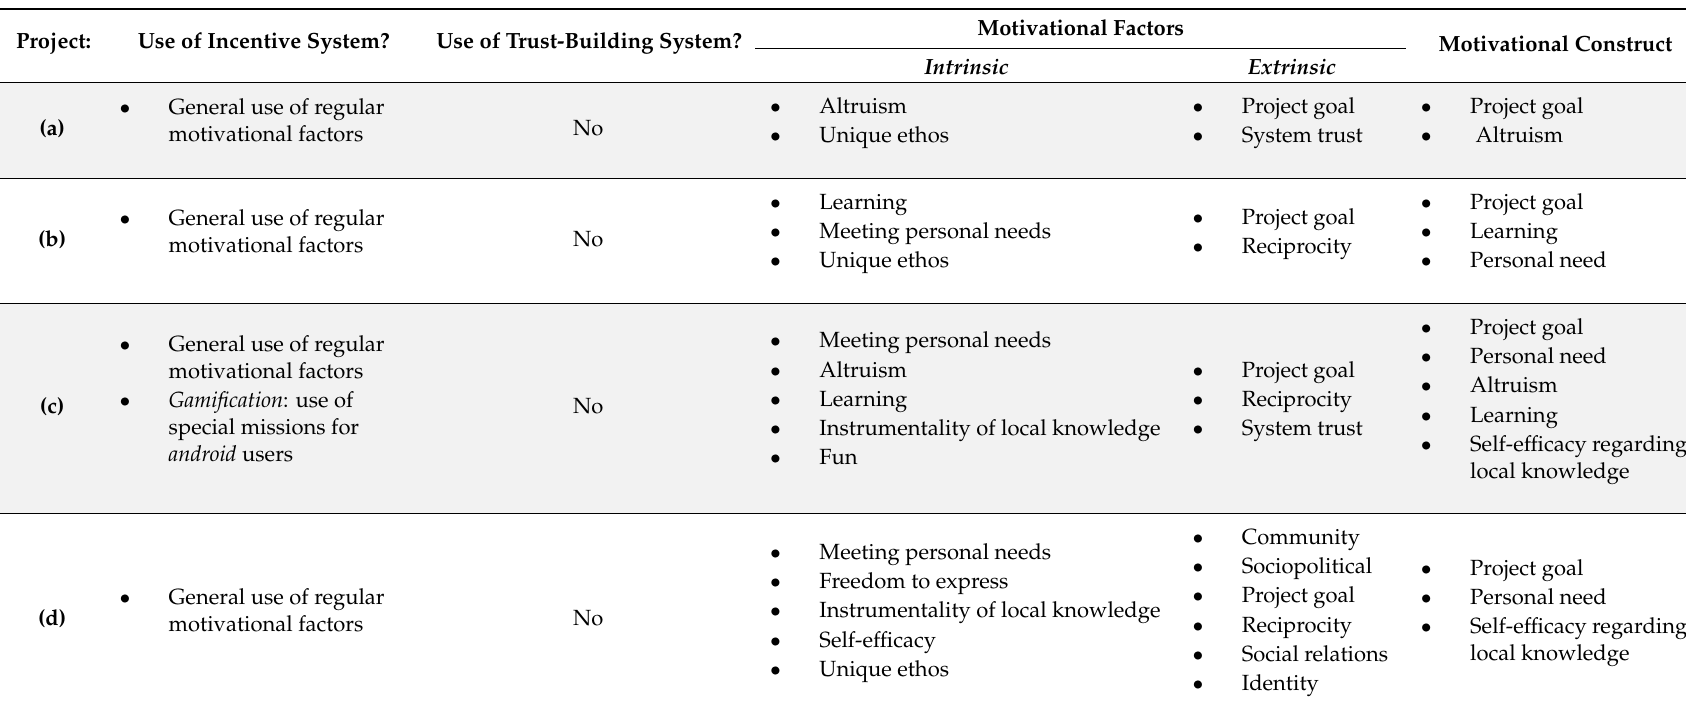
Table 8. VGI Participation